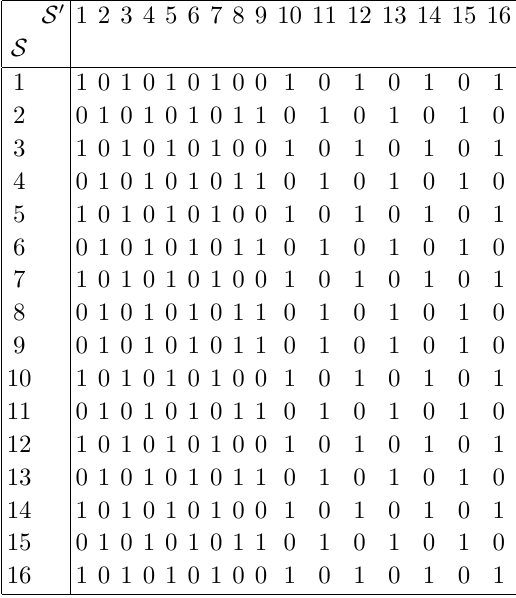
Table 37 . Gadget values for P